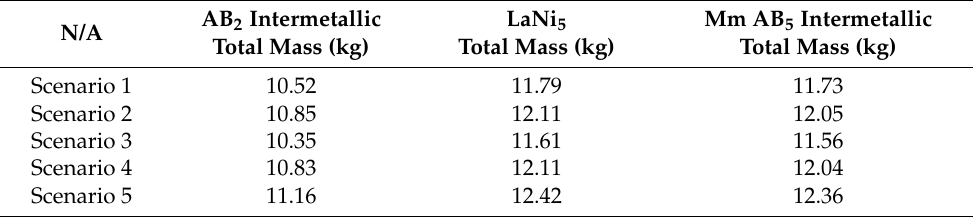
Table 4. Total weight of the system for all the thermal management scenarios.